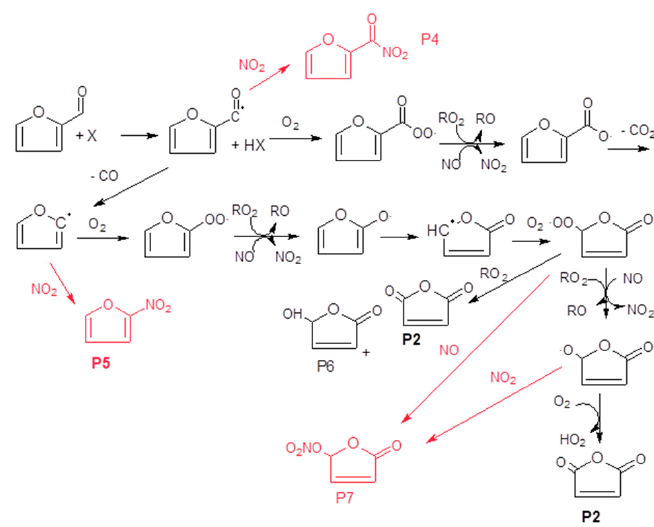
Scheme 2. General hydrogen abstraction mechanism in the reaction of furfural with atmospheric oxidants X (Cl atoms, OH or NO 3 radicals). The proposed route for the reaction in the presence of NOx is shown in